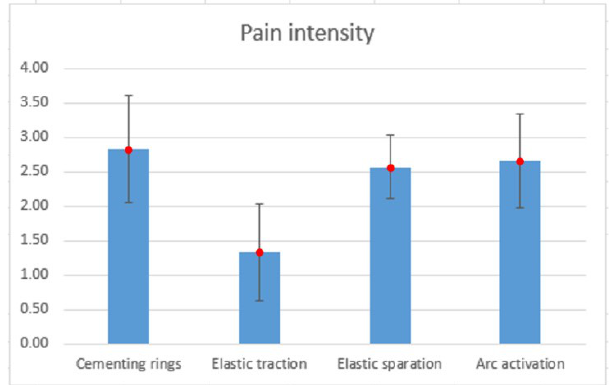
Figure 7. Graphical representation of pain